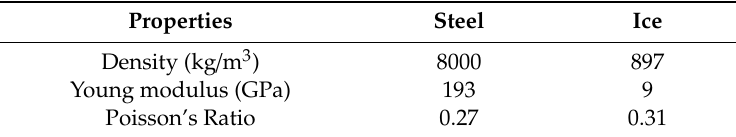
Table 1. Ice and steel material